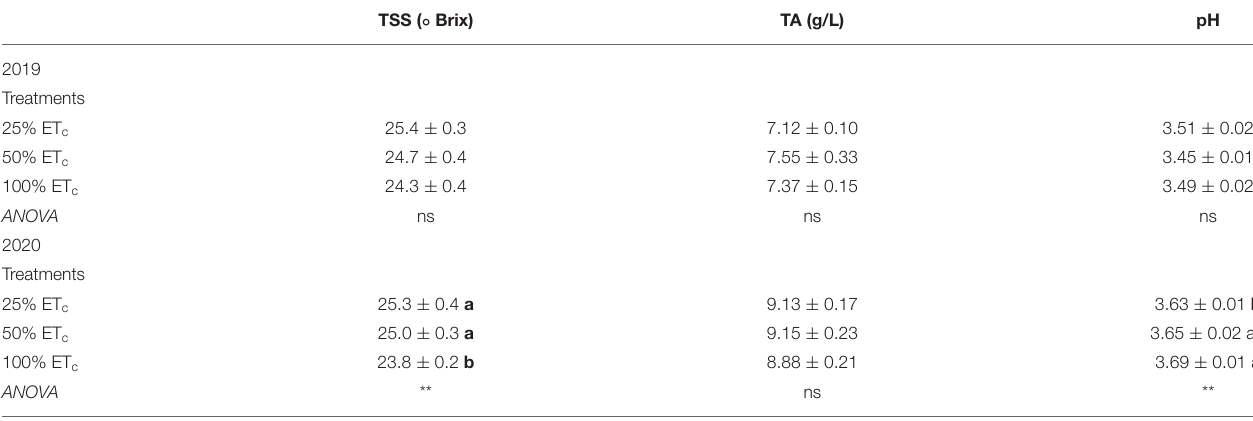
TABLE 2 | Total soluble solids (TSS), titratable acidity (TA) and pH of Cabernet Sauvignon grapevines (clone FPS08) subjected to different replacement of crop evapotranspiration (25, 50, and 100% ET c ), collected at harvest in Oakville, CA, in 2018–2019 and 2019–2020 seasons.